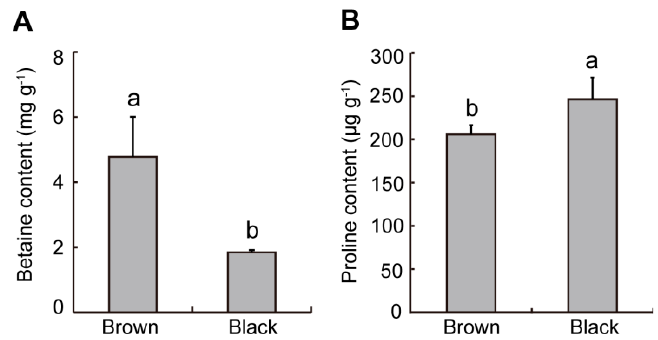
Figure 4. Determination of osmotic regulating substances in dimorphic seeds of S. liaotungensis . ( A ) Betaine content. ( B ) Proline content. Different letters show significant differences ( t - test, p < 0.05).